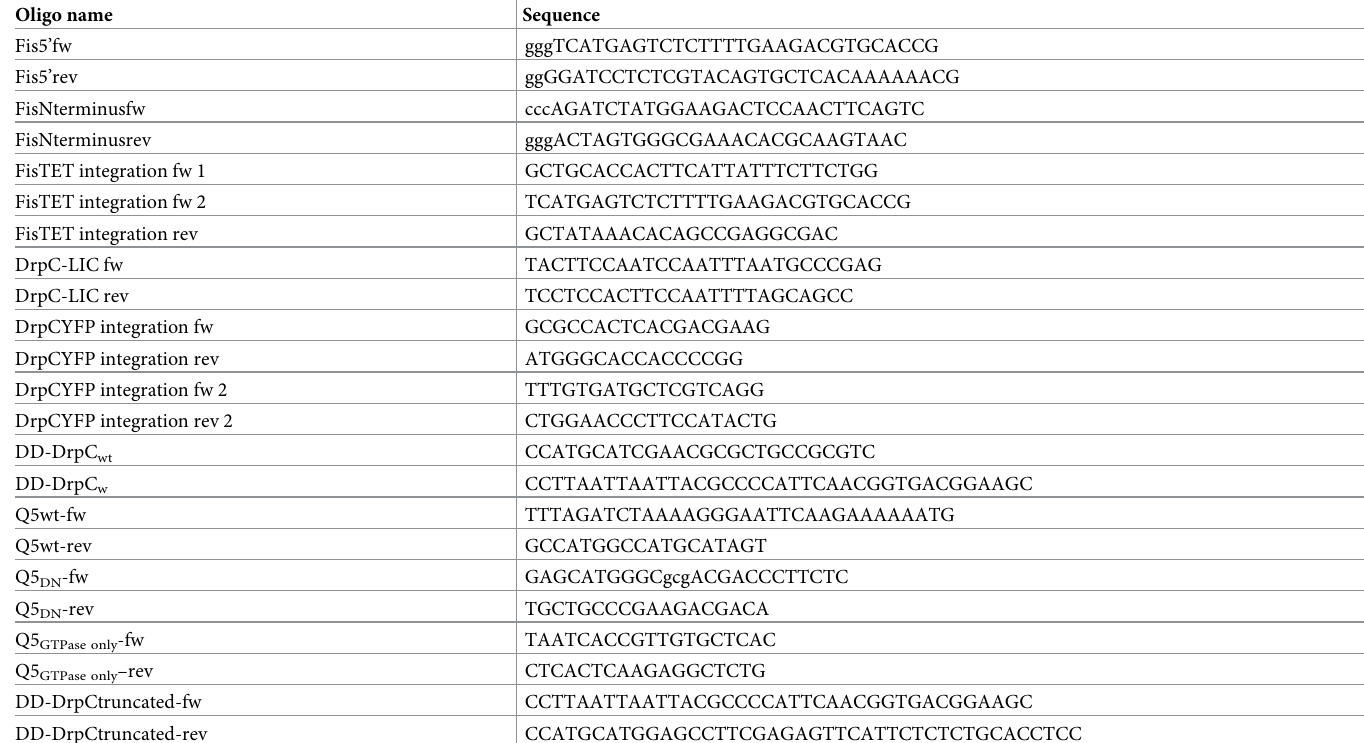
Table 2. Oligonucleotides